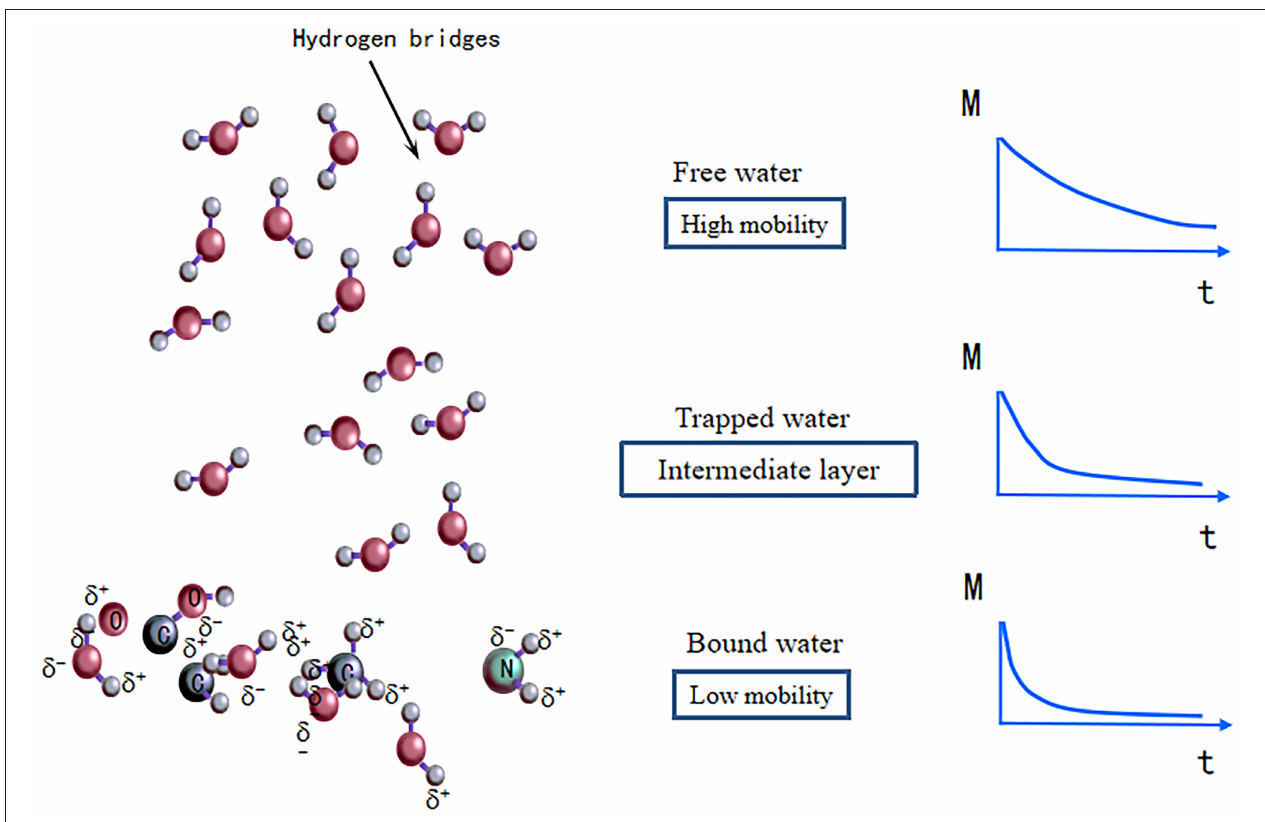
FIGURE 3 | Schematic illustration of the three water phase models (bound water, trapped water, and free